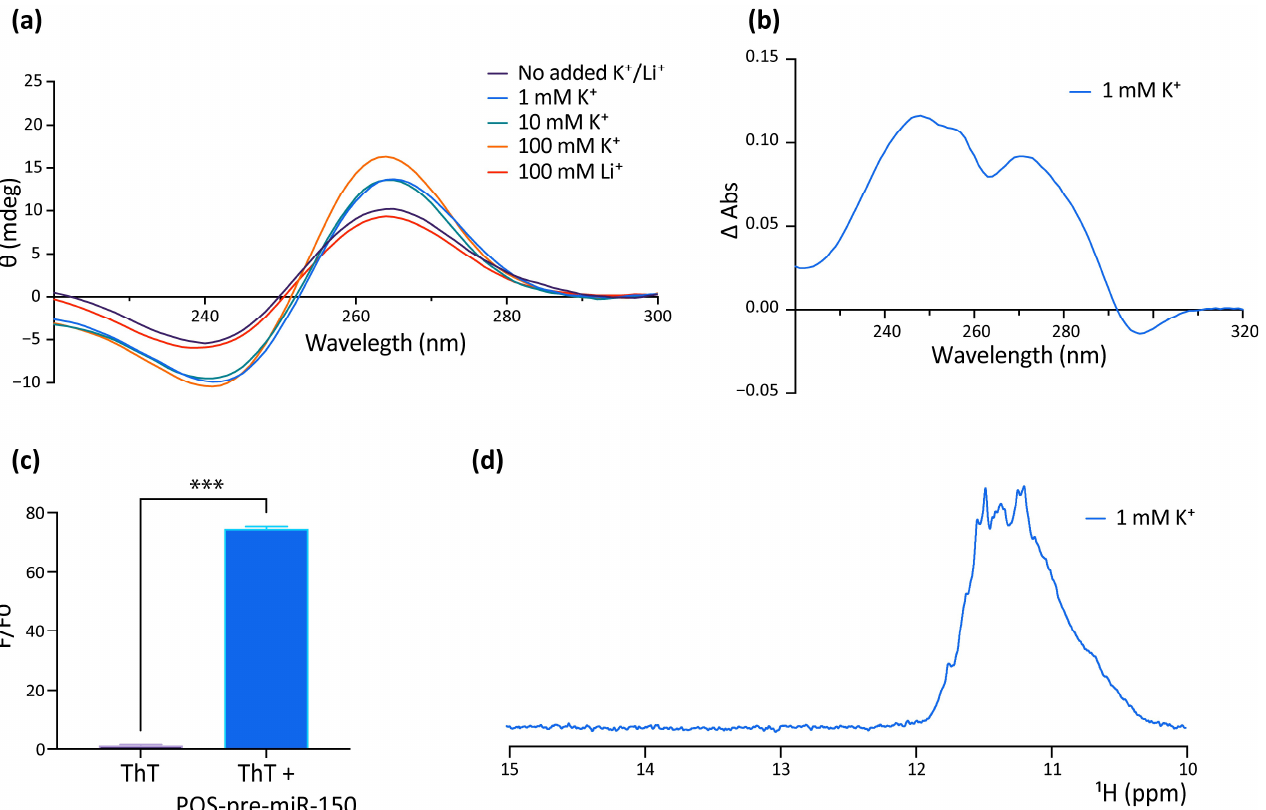
Figure 2. In vitro evidence of the formation of a G4 structure in the PQS present in pre-miR-150. ( a ) CD spectroscopy of the folded RNA oligonucleotide containing the pre-miR-150 PQS in different K + and Li + concentrations. ( b ) TDS spectrum of the RNA oligonucleotide containing the pre-miR-150 PQS (70 °C spectrum–20 °C spectrum) folded in the presence of 1 mM K + . ( c ) ThT fluorescence assay with the RNA oligonucleotide containing the pre-miR-150 PQS folded in the presence of 1 mM K + . Two-tailed t -Student, *** indicates p < 0.0001. ( d ) Imino proton region of the 1D 1 H NMR spectrum of the RNA oligonucleotide containing the pre-miR-150 PQS folded in the presence of 1 mM K + .